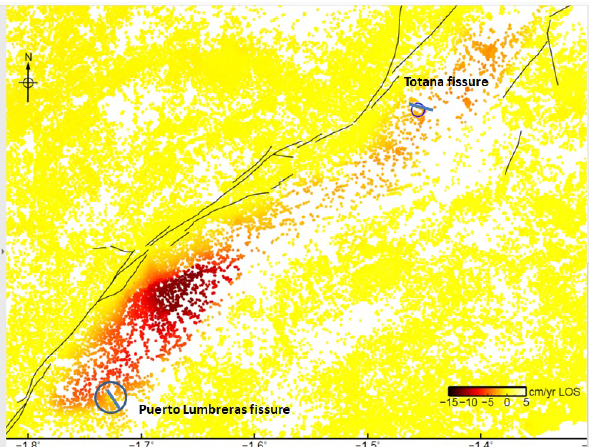
Figure 8. Locations of both fissures on the SAR interferometry de- formation map of the Guadalentín Valley from Envisat 2003–2010. Continuous black lines represent surficial